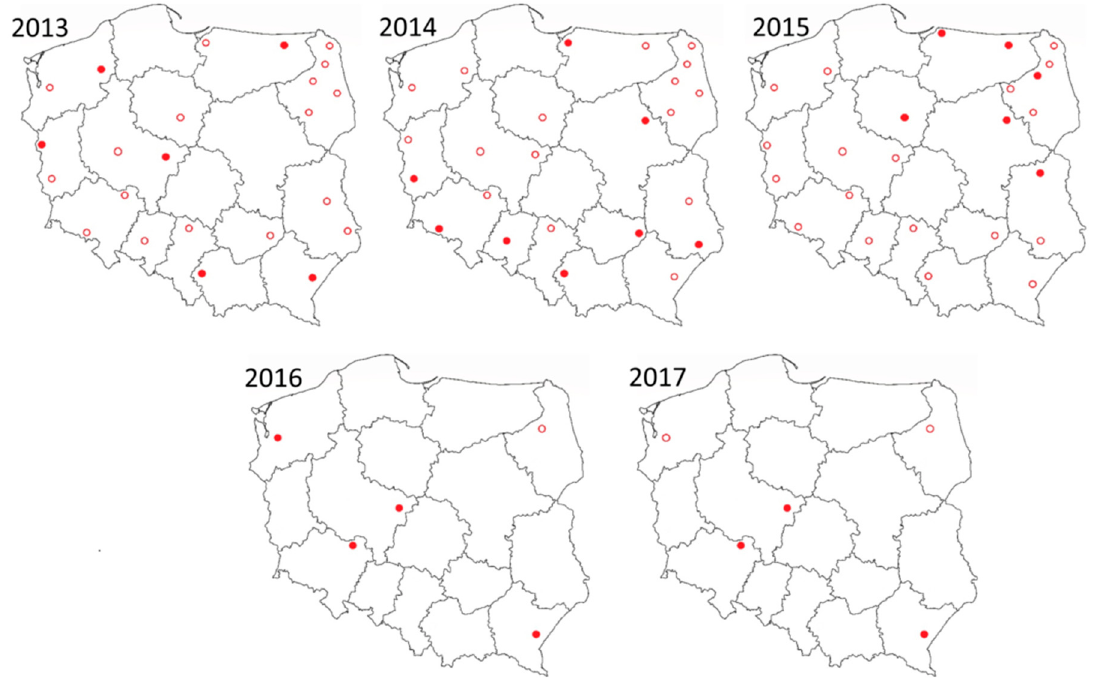
Figure 1. Culicoides trapping locations in Poland between 2013 and 2017. Red circle represents location of trap were no positive samples were detected, while red disc trap locations indicate where SBV was detected in Culicoides . From 2016 only targeted surveillance in five locations was performed.